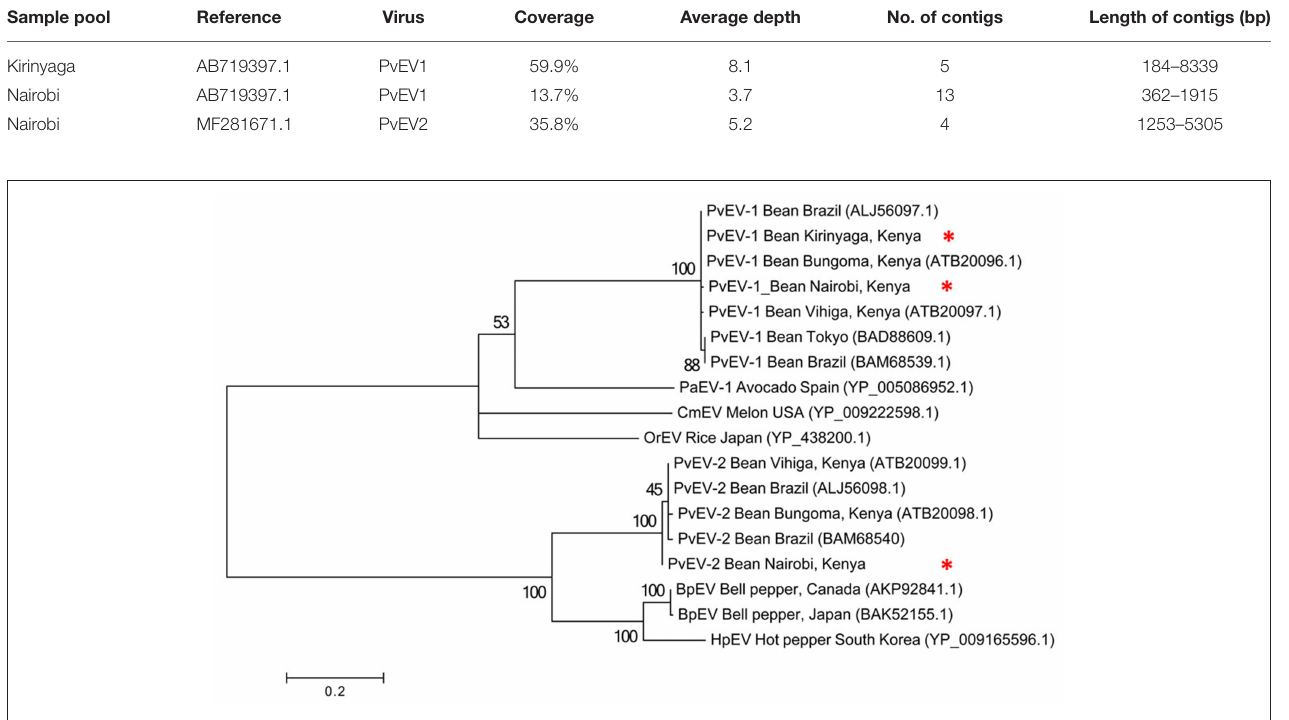
FIGURE 3 | Phylogenetic analysis of Phaseolus vulgaris alphaendornavirus 1 (PvEV1) and PvEV2 isolates from farms in Kirinyaga County and Nairobi University Research Farm, Kabete with other endornavirus strains using the viral helicase (Hel-1) protein. The phylogeny was based on aligning 235 amino acids of the viral Hel-1 helicase sequence. The evolutionary history was inferred by the Maximum Likelihood Method based on the WAG substitution model ( Whelan and Goldman, 2001) with 1,000 bootstraps in MEGA version 6. PaEv, Persea americana alphaendornavirus 1; CmEV, Cucumis melo alphaendornavirus; OrEV, Oryza sativa alphaendornavirus; BpEV, bell pepper alphaendornavirus; HpEV, hot pepper alphaendornavirus. Endornavirus sequences identified in this study are indicated by